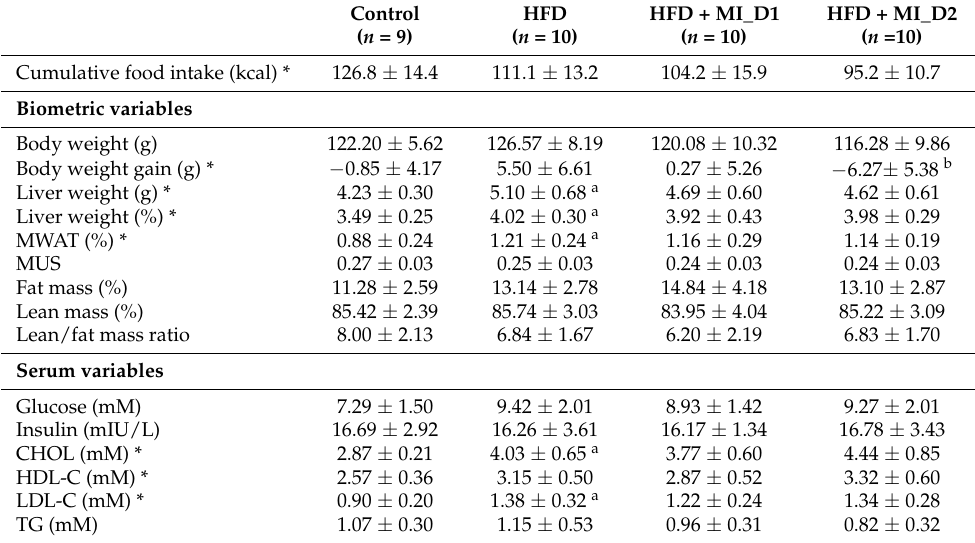
Table 2. Effects of HFD and multi-ingredient treatment at two doses (HFD + MI_D1 and HFD + MI_D2) on food intake and biometric and serum variables at the end of the study (week